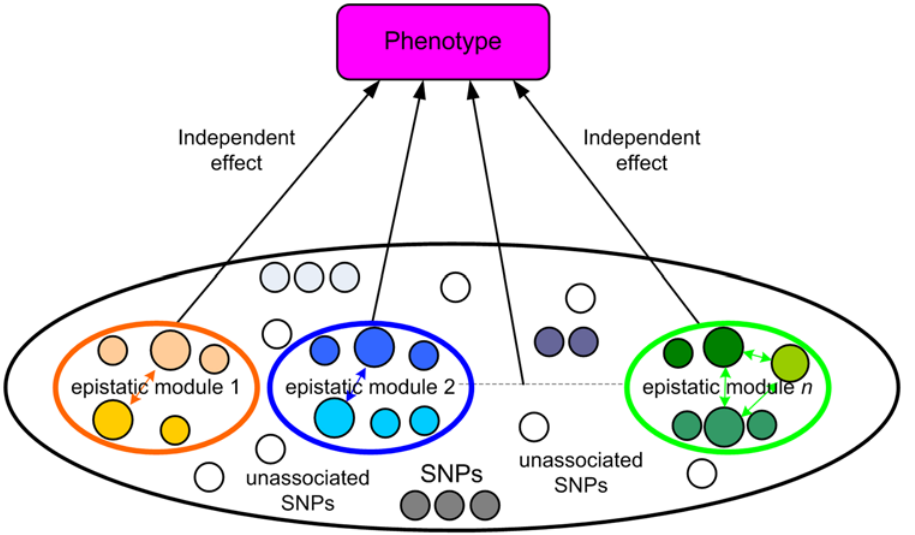
Figure 1. Relationship between phenotype and genotype, illustrated with epistatic modules. Disease-associated SNPs are contained in epistatic modules. Disease-unassociated SNPs are outside the modules. SNPs with the same color form an LD